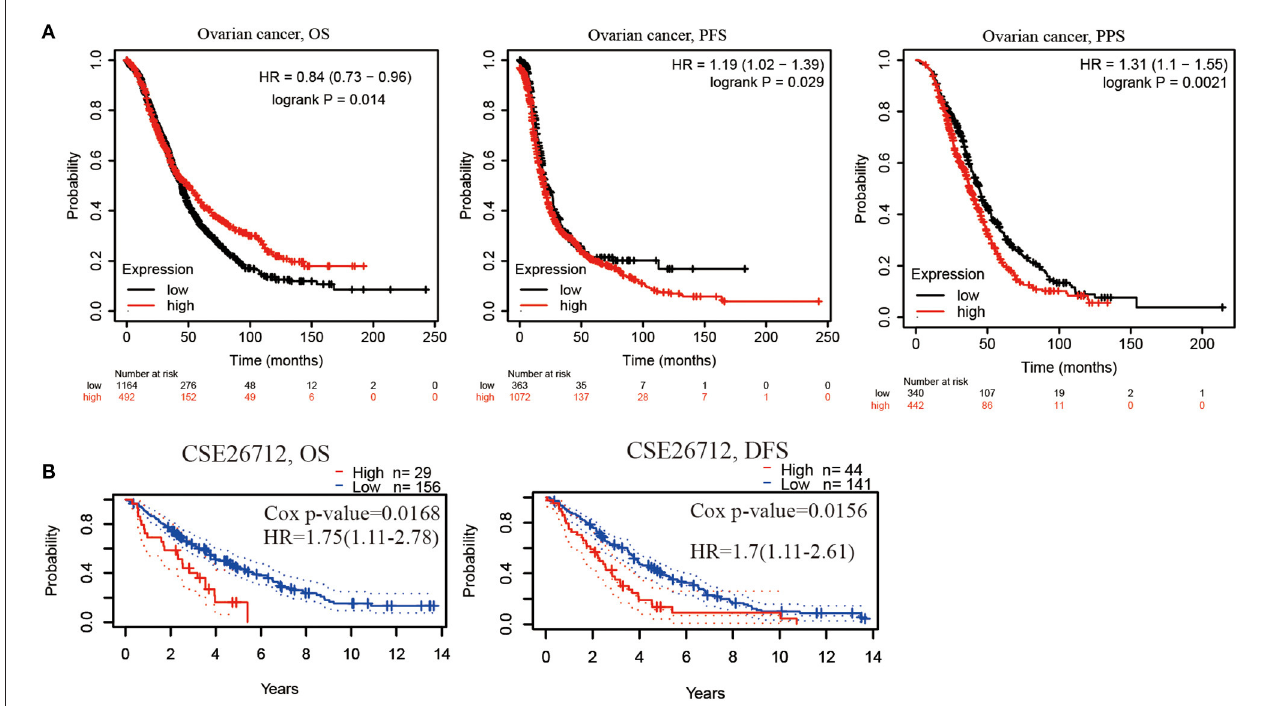
FIGURE 2 | Prognostic value of PER1 mRNA expression in OV patients. (A) Low PER1 expression was associated with poor OS in BC patients using Kaplan–Meier Plotter, and high expression of PER1 was associated with poor PFS and PPS. (B) Survival curve from PrognoScan analysis for OS and DFS of patients with OV. OS, Overall survival; PFS, Progression-free survival; DFS, disease-free survival; PPS, Post Progression survival.